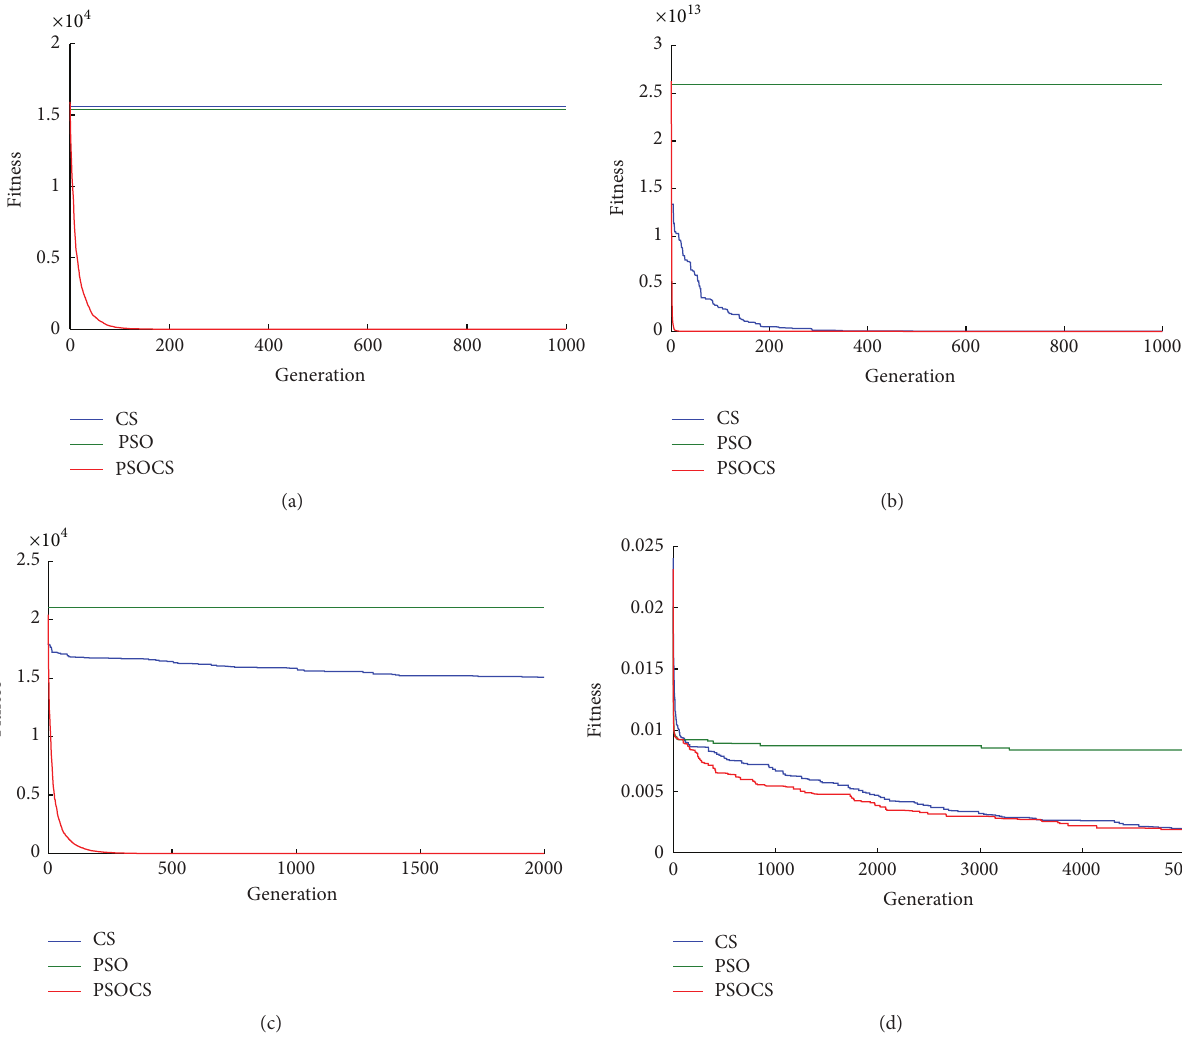
Figure 4: Change trend of average optimal fitness value.